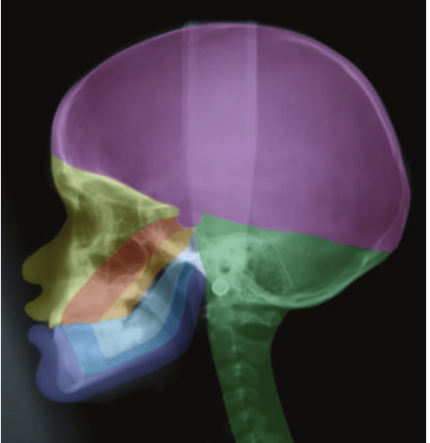
Figure 2: The embryological development of the cranium, jaws, and teeth from the neural crest and the notochord shown schematically in colours on a profile radiograph. The different fields in the mandible are marked in blue. The fields in the maxilla are marked in yellow (the frontonasal field), in red (the maxillary field), and in orange (the palatinal field). The theca cranii field is marked in purple and the occipital/cerebellar field in green [50].